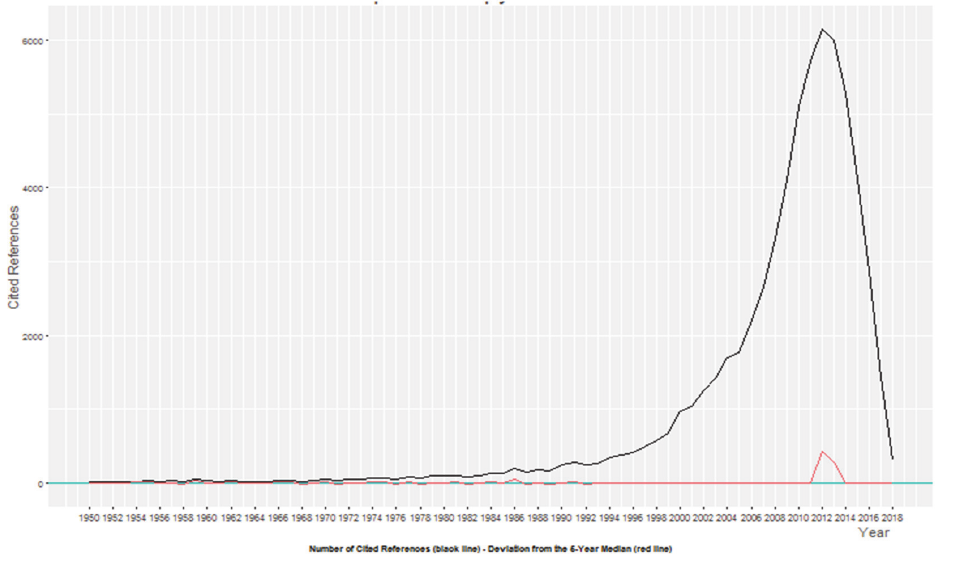
Fig. 6. Reference Publication Year